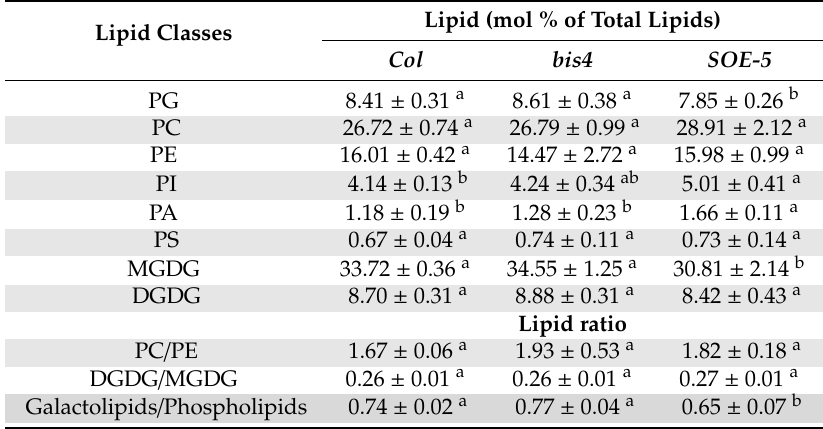
Table 2. Membrane lipid composition in each head-group class and lipid ratio in Col , bis4, and SOE-5 plants.